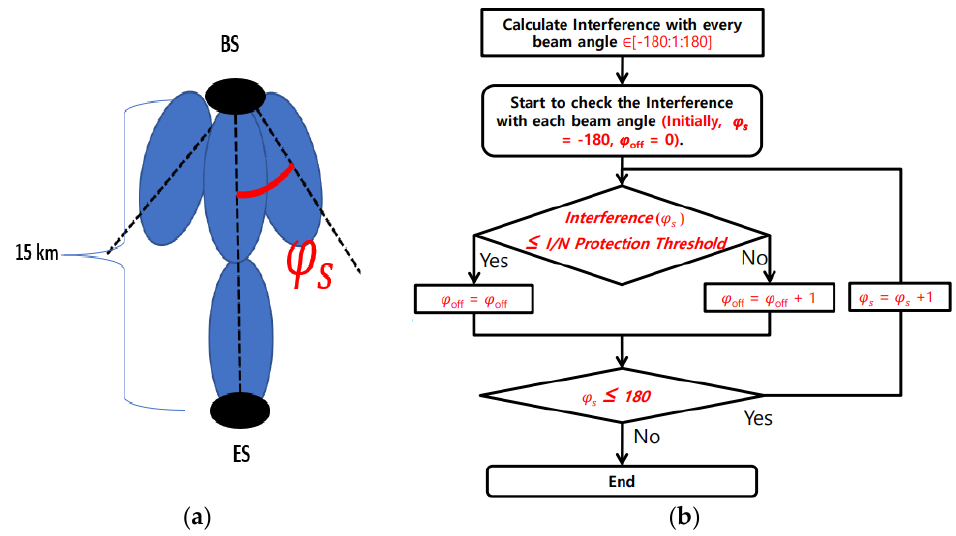
Figure 3. Fixed base station to Earth station: ( a ) relative azimuth and ( b ) flux gram.